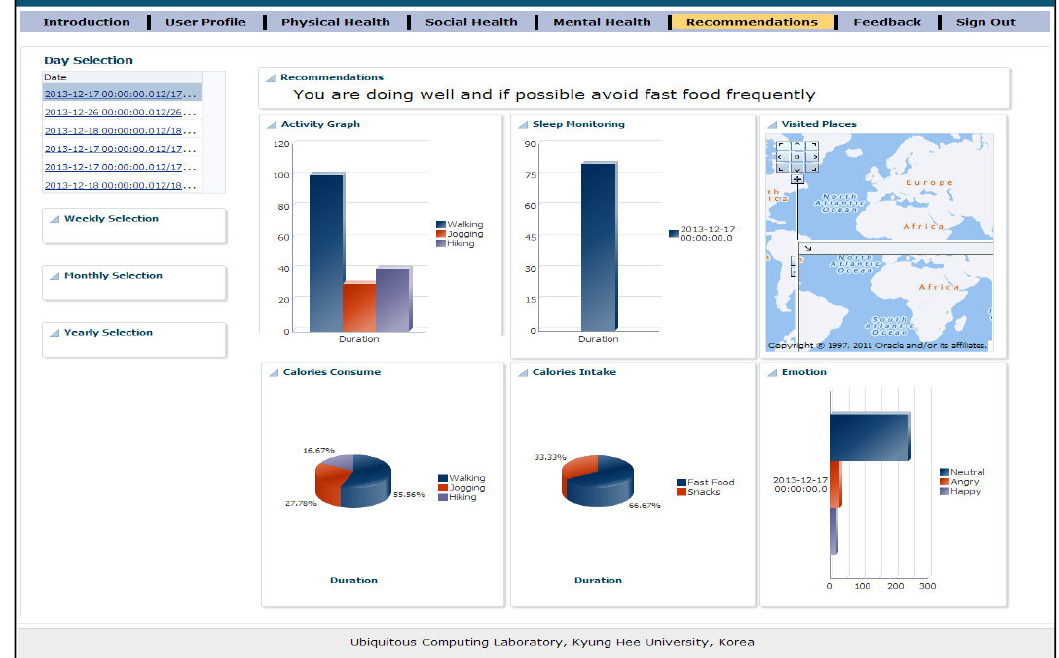
Figure 6. Dashboard of daily routines and appropriate